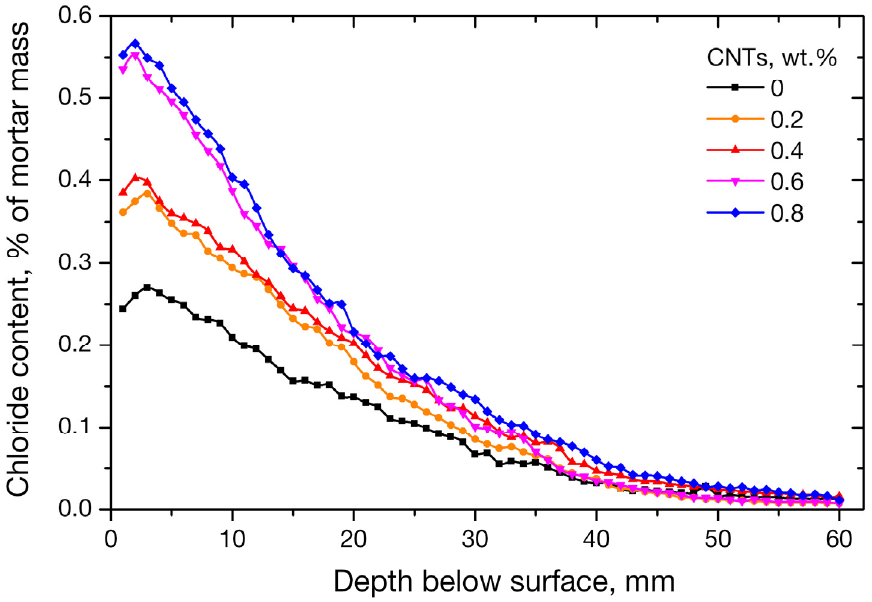
Figure 7. Chloride profile of the nano-modified mortars at different depths.